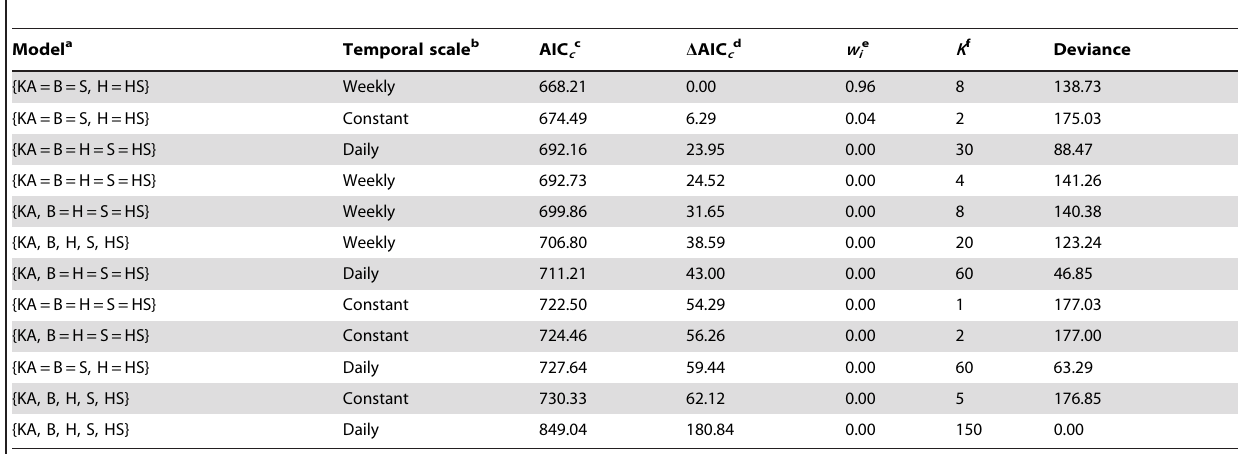
Table 4. Survival models using Program MARK for white-tailed deer from birth to 30 days using known-age newborn fawns and ages estimated from published neonatal-age models based on new-hoof growth, South Dakota and Minnesota, USA, 2001–2009.